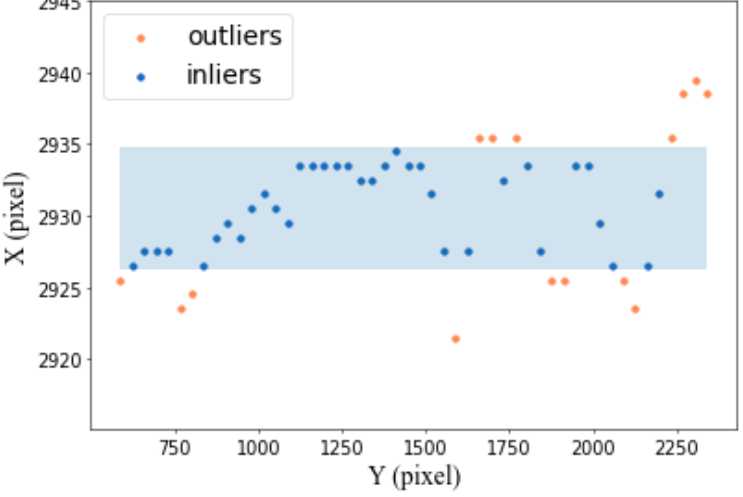
Figure 12. Outlier detection method based on Gaussian distribution.